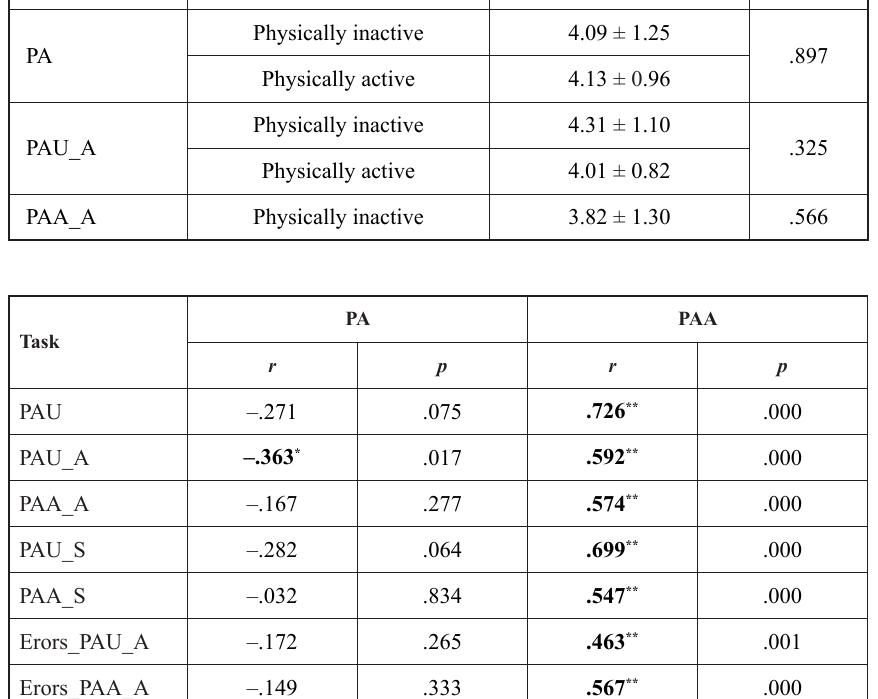
Table 3. Dual task effect on cog - nitive functions in subjects in the aspect of their physical activity